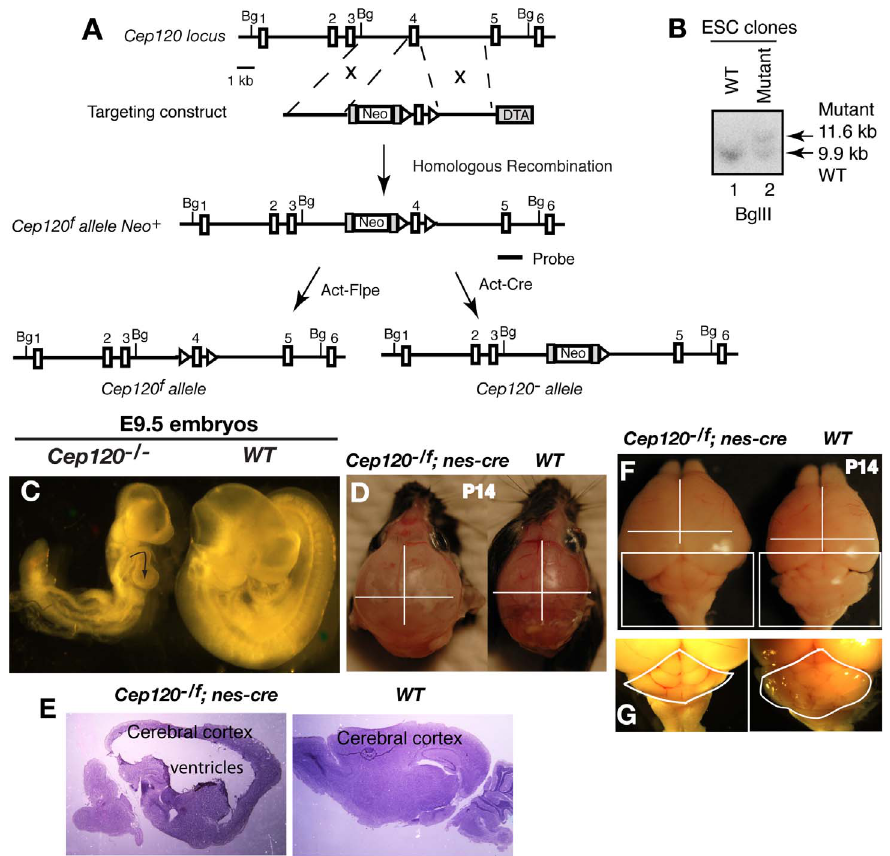
Figure 3. Loss of Cep120 results in early embryonic lethality, hydrocephalus, and cerebellar hypoplasia in mice. (A) The gene targeting strategy used to create mouse Cep120 - and Cep120 f mutant alleles. Open rectangles refer to exons (which are numbered), lines to introns, grey rectangles to Frt sites, and triangles to loxP sites. BglII (Bg) restriction sites and a probe for Southern blot are indicated. Neo, neomycin gene; DTA, diphtheria toxin A gene. (B) Southern blot analysis shows a representative mutant and wild type (wt) ES cell clones. (C) Lateral view of wild type and Cep120 -/- embryos. Note that the development of Cep120 mutant embryos is delayed and the heart loops in the opposite direction (indicated by the arrow). (D–G) Morphology of two-week-old (P14) unskinned mouse heads (D), brains (E, F), and cerebellums (G), with indicated genotypes. The lines are in the same length for both wt and mutant, thus indicating the relative brain size or the extent of hydrocephalus in the mutant. Hematoxylin and eosin (H&E) staining of sagittal brain sections (E) confirms that the mutant ventricles of the brain are severely dilated. The boxed area in F is enlarged in (G). Cerebellums are outlined. The mutant cerebellum is significantly smaller (F).